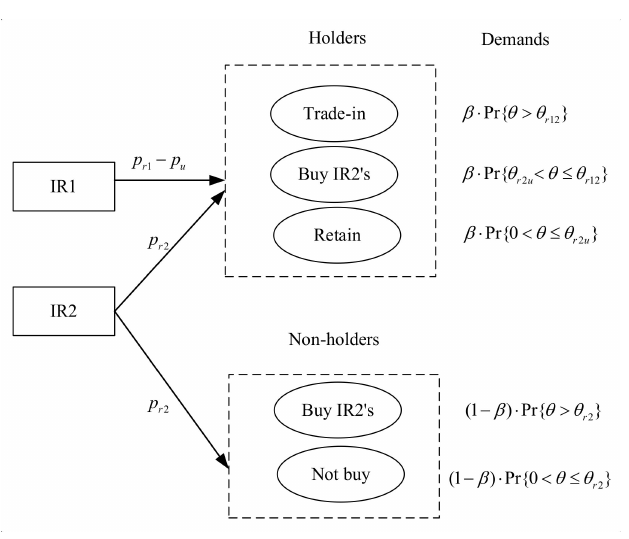
Figure 2. Consumer choices and demand for products from two